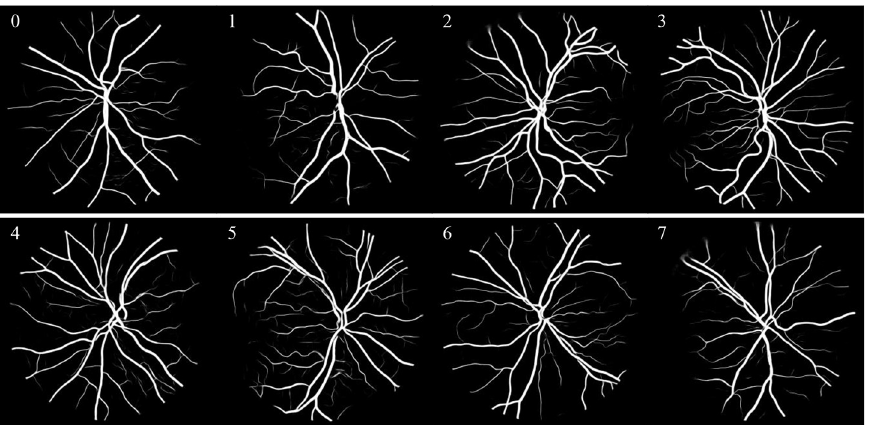
Fig 7. CHASE DB1 datastes segmentation